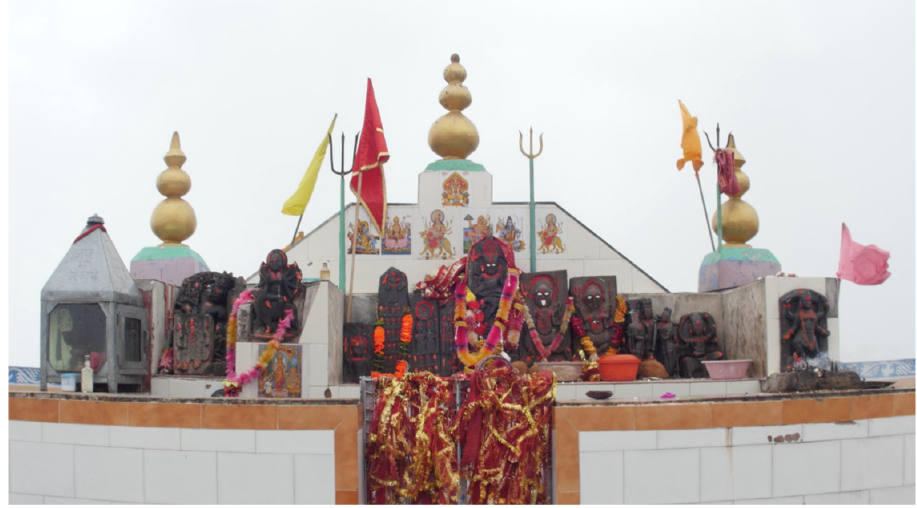
Figure 6. Deities of the Shikari Devi shrine. Credit: Nadav Harel.